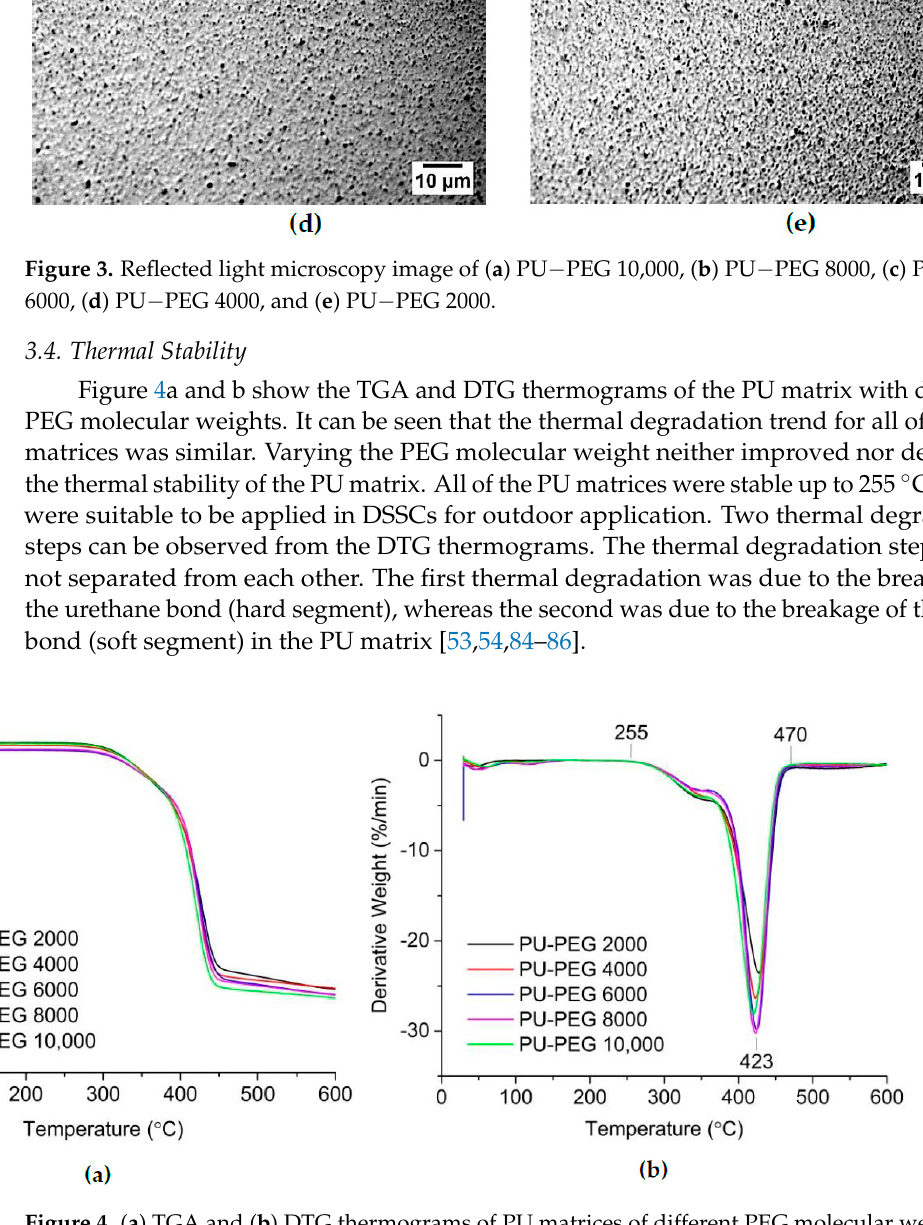
Figure 4. ( a ) TGA and ( b ) DTG thermograms of PU matrices of different PEG molecular